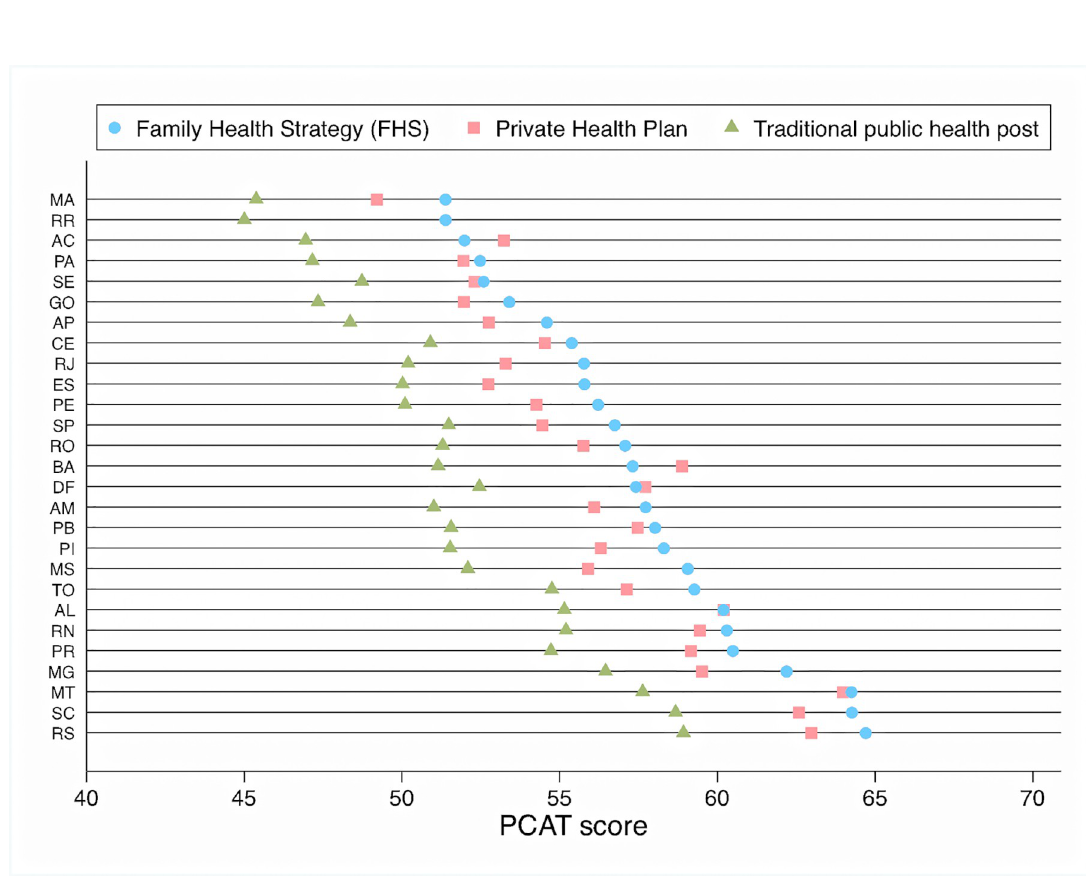
Fig 1. Adjusted PCAT scores, by main type of healthcare coverage and Brazilian state. Numbers are mean PCAT scores (from 0 to 100), adjusted for all variables in model 3, Table 2 and stratified by type of healthcare coverage. MA (Maranh ã o), RR (Roraima), AC (Acre), PA (Para´), SE (Sergipe), GO (Goia´s), AP (Amapa´), CE (Ceara´), RJ (Rio de Janeiro), ES (Espı´rito Santo), PE (Pernambuco), SP (S ã o Paulo), RO (Rondoˆnia), BA (Bahia), DF (Distrito Federal), AM (Amazonas), PB (Paraı´ba), PI (Piauı´), MS (Mato Grosso do Sul), TO (Tocantins), AL (Alagoas), RN (Rio Grande do Norte), PR (Parana´), MG (Minas Gerais), MT (Mato Grosso), SC (Santa Catarina), RS (Rio Grande do Sul). � Insufficient sample size to calculate score for private health plan holders in Roraima (RR).